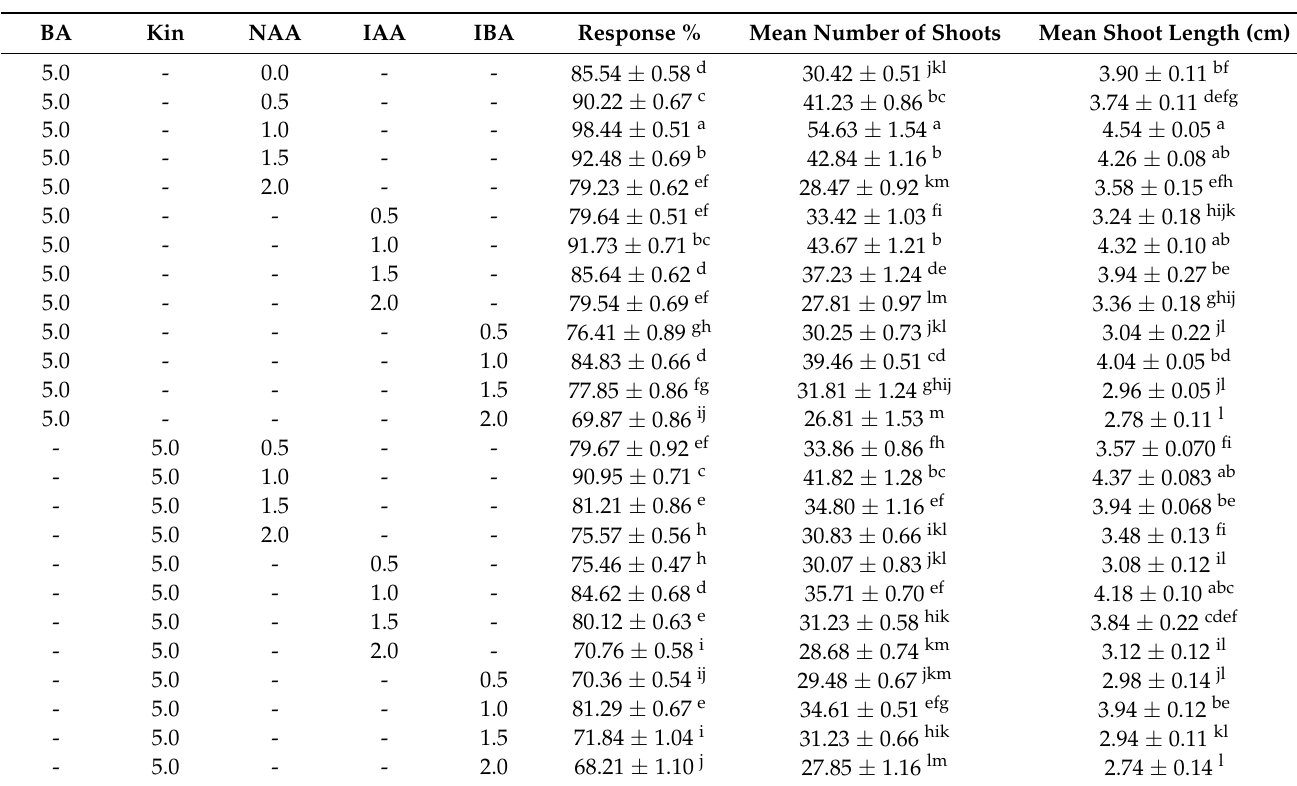
Table 3. Effect of auxins (IAA or IBA) with optimal concentrations of BA (5.0 µ M) and Kin (5.0 µ M) on shoot multiplication in callus mass obtained from internodal explants after 8 weeks of culture.